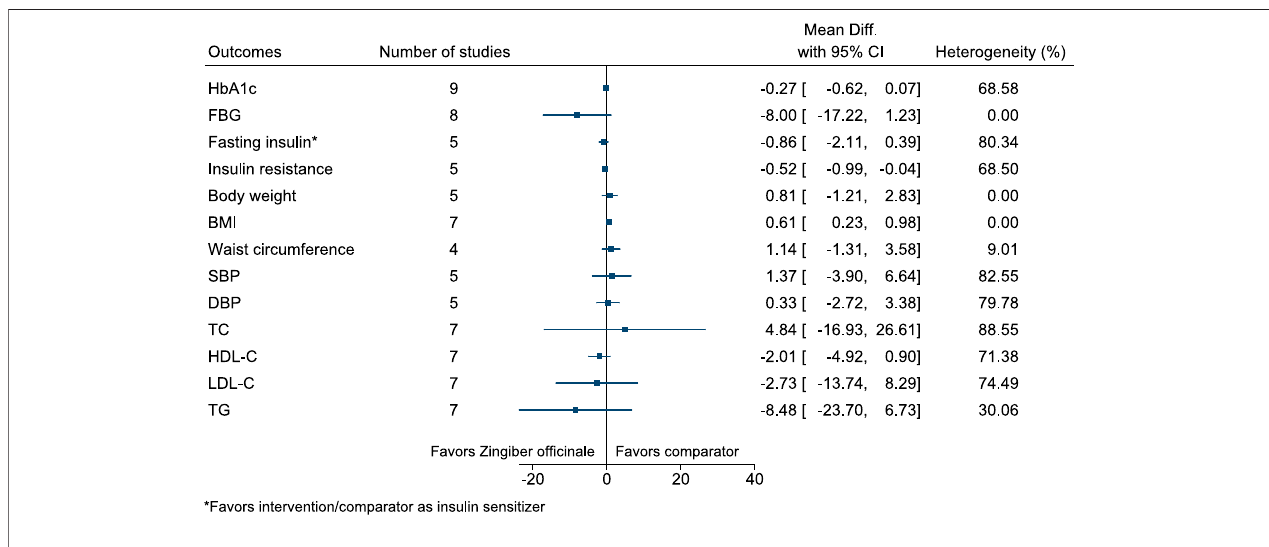
FIGURE 36 | Zingiber of fi cinale — Summary forest